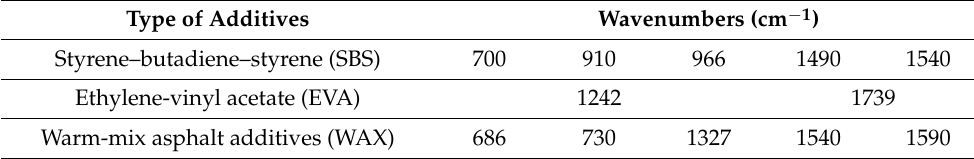
Figure 8. Spectrum of 2500–3000 cm − ¹ area . Table 2. Particular wavenumbers of each